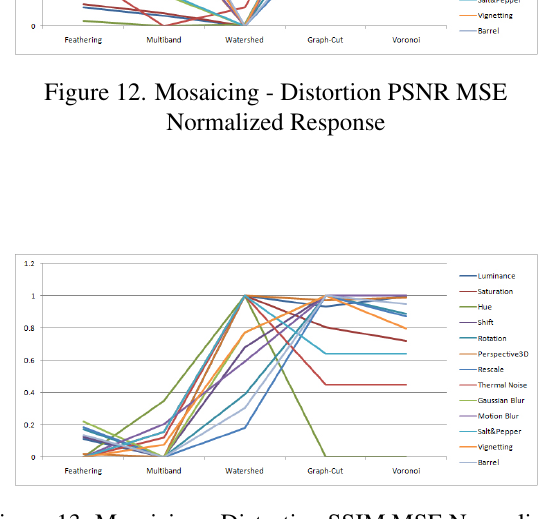
Figure 13. Mosaicing - Distortion SSIM MSE Normalized Response